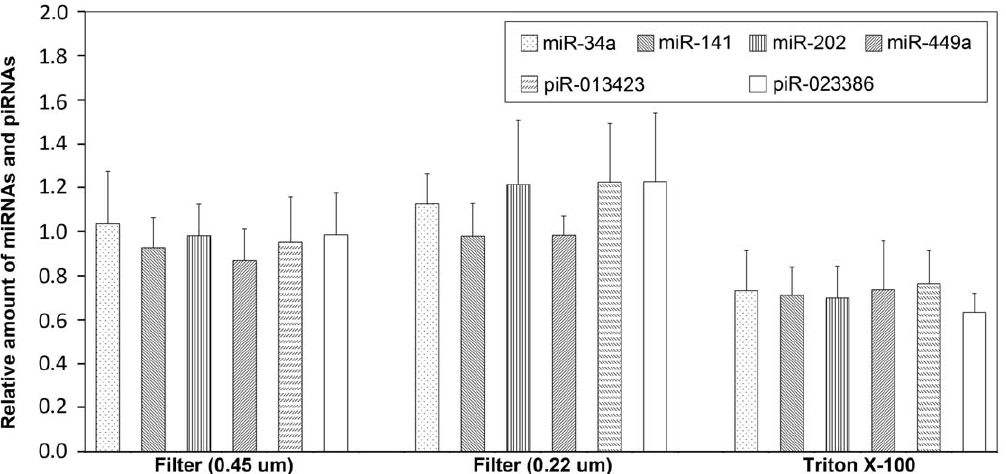
Figure 1. The effect of filtration and Triton X-100 on the amount of cfs-miRNAs. Seminal plasma was filtered through 0.45-, and 0.22- m m pores, or incubated with 1% (v/v) Triton X-100 at room temperature for 20 min. The amount of miRNAs was normalized to the unfiltered aliquot. Each column represents the mean of 5 independent samples. Error bars indicate the SD.